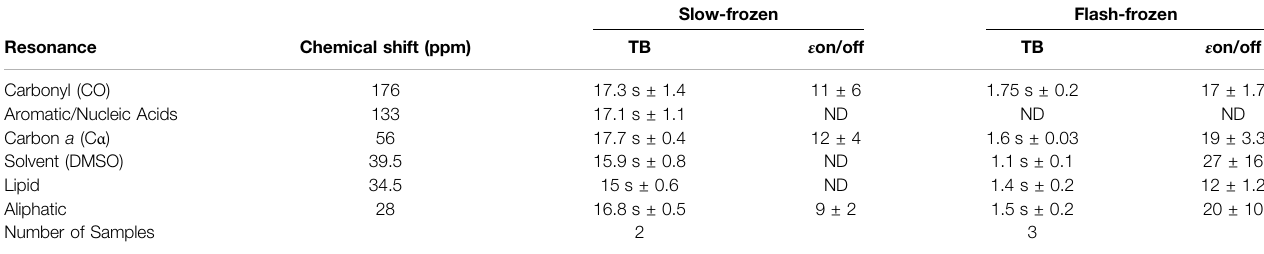
TABLE 2 | Average T B values and enhancements ( ε on/off ) of slow-frozen Jurkat T cells compared to fl ash-frozen Jurkat T cells.